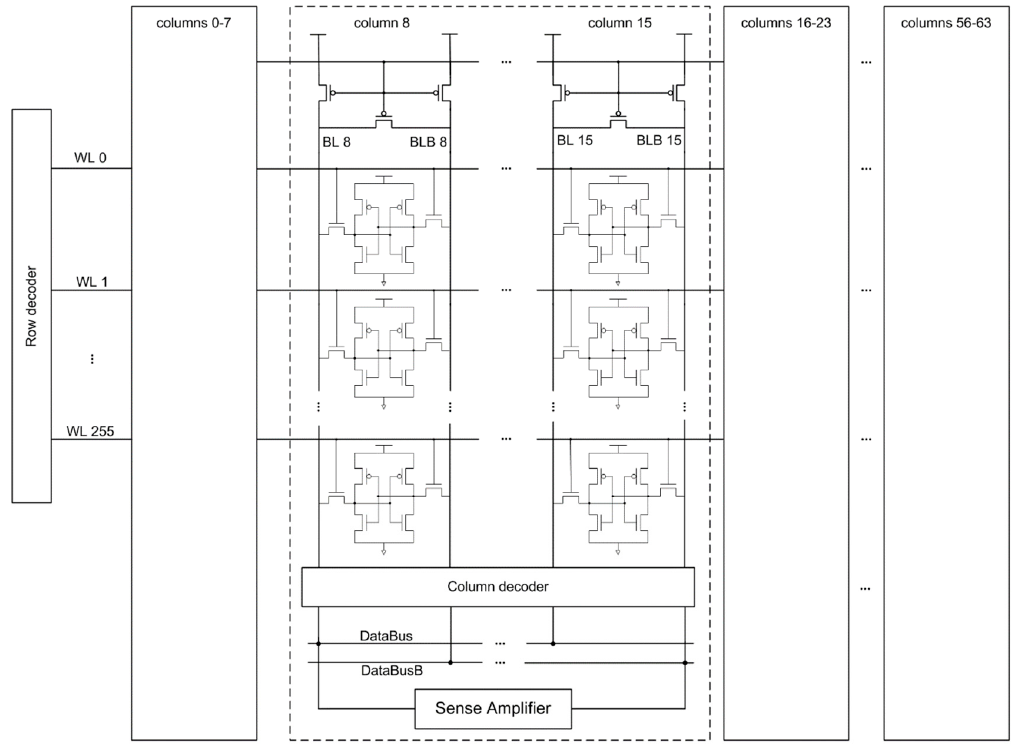
Figure 2. Diagram of the SRAM memory. It has a total of 16,384 cells, structured in 256 rows and 64 columns.